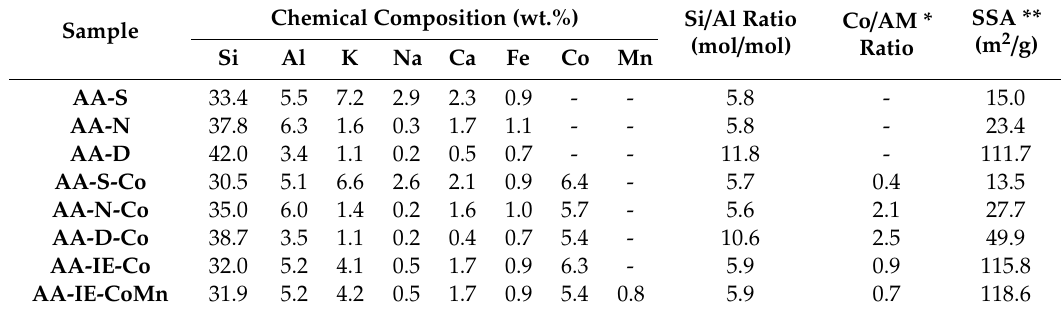
Table 1. Chemical composition and specific surface area of catalysts and zeolite foam supports.